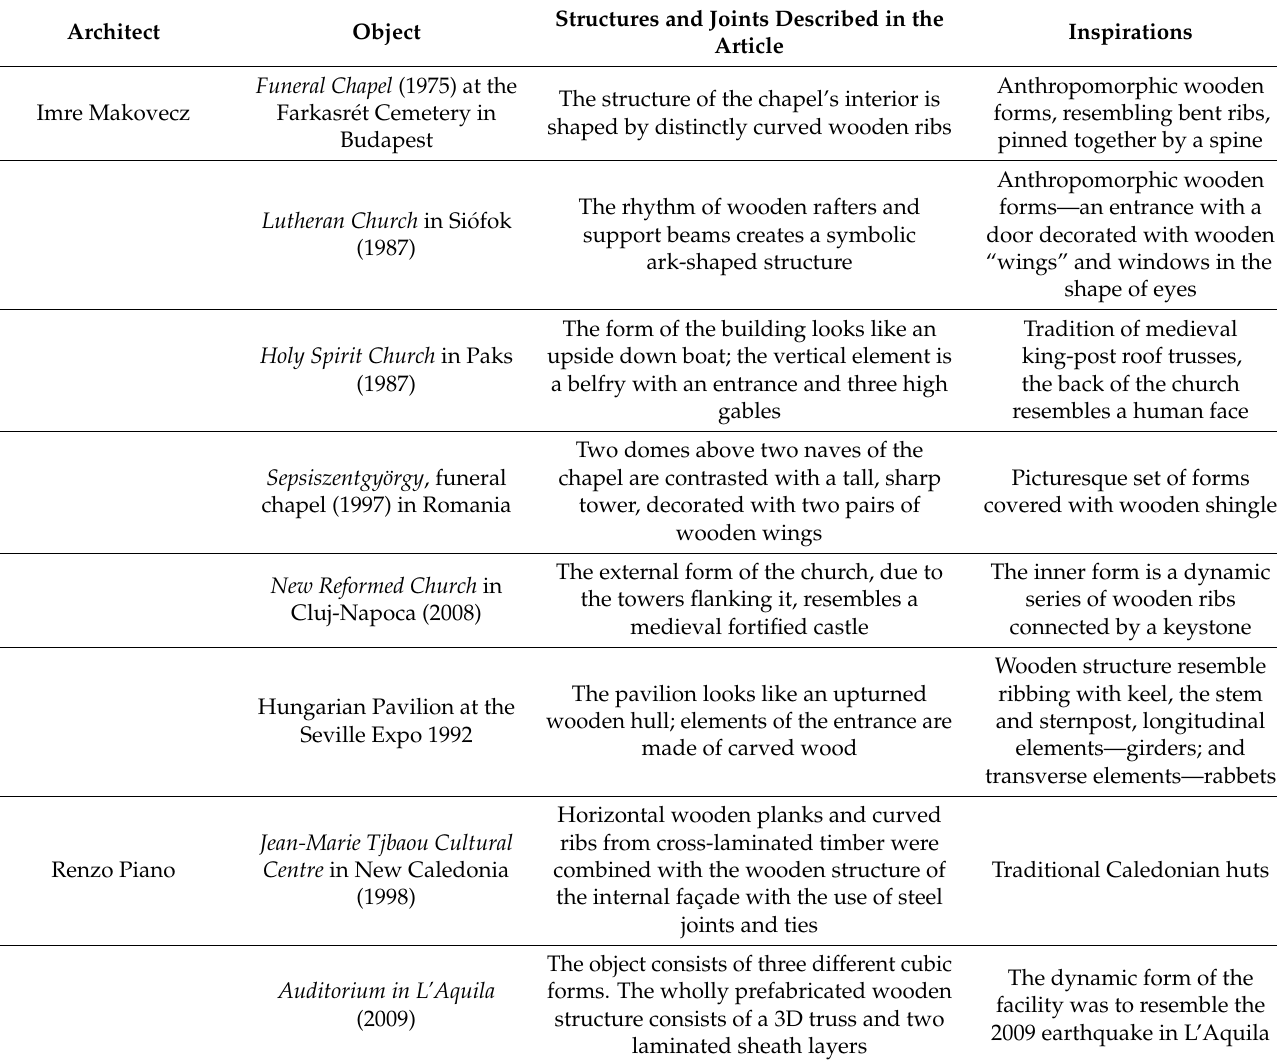
Table 1. Contains and organizes the discussed in chapter 5: constructions, original or modified historical joints, and their